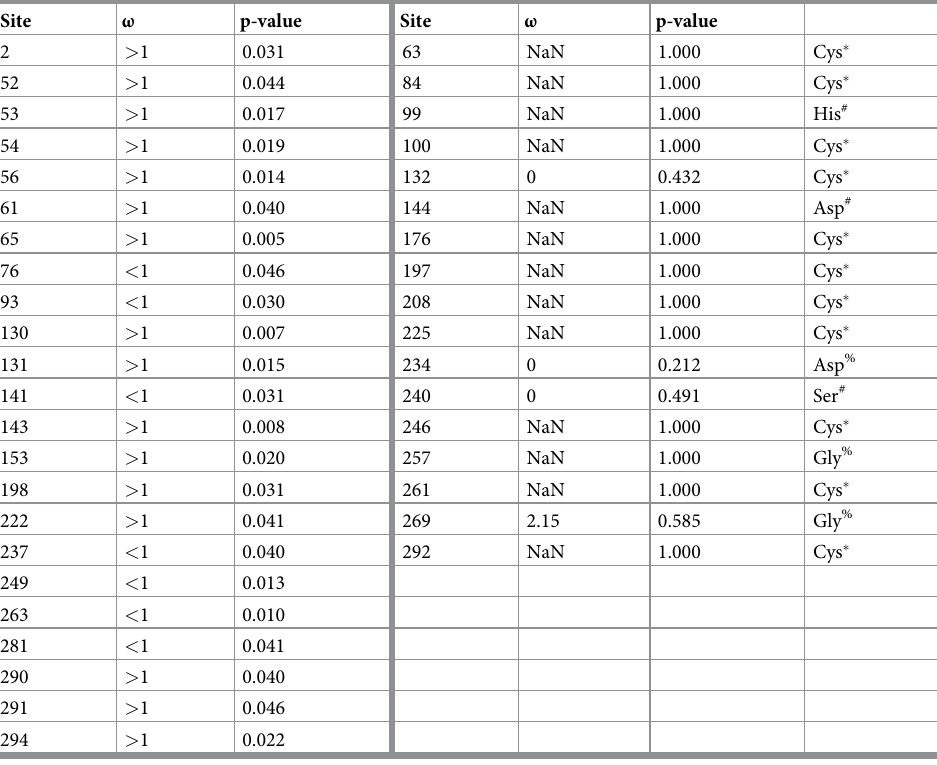
Table 4. Codons affected by selective pressure in SVTLE